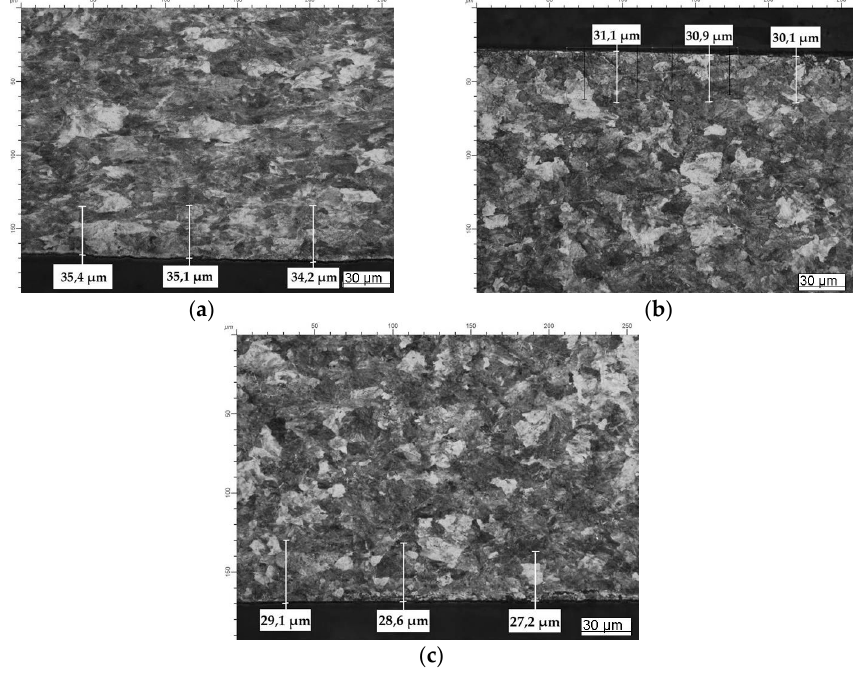
Figure 8. Thickness of the fine grain layer after drawing through α = 5 deg die: ( a ) soft friction condition; ( b ) medium friction condition; and ( c ) hard friction condition.